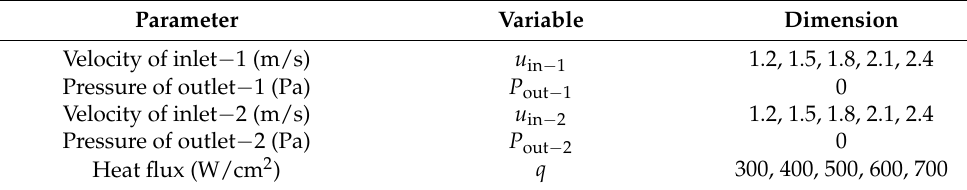
Table 2. The summary of the MDMC structure boundary conditions. Parameter Variable